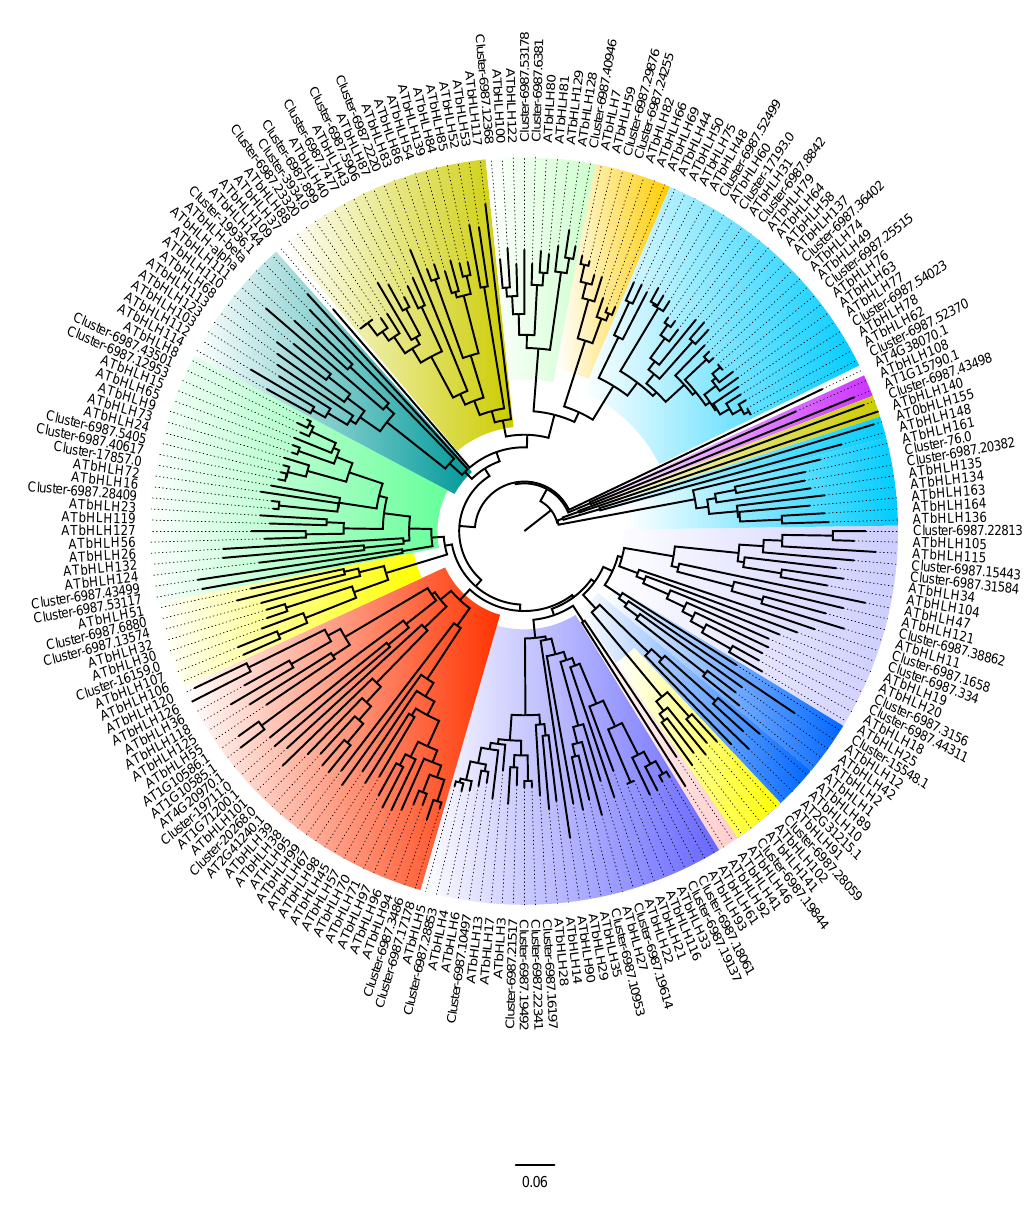
Figure 1. Phylogenetic analysis of the D. kaki bHLH proteins compared to A. thaliana . Different colours represent different family groups, and the detail groups are shown in Table